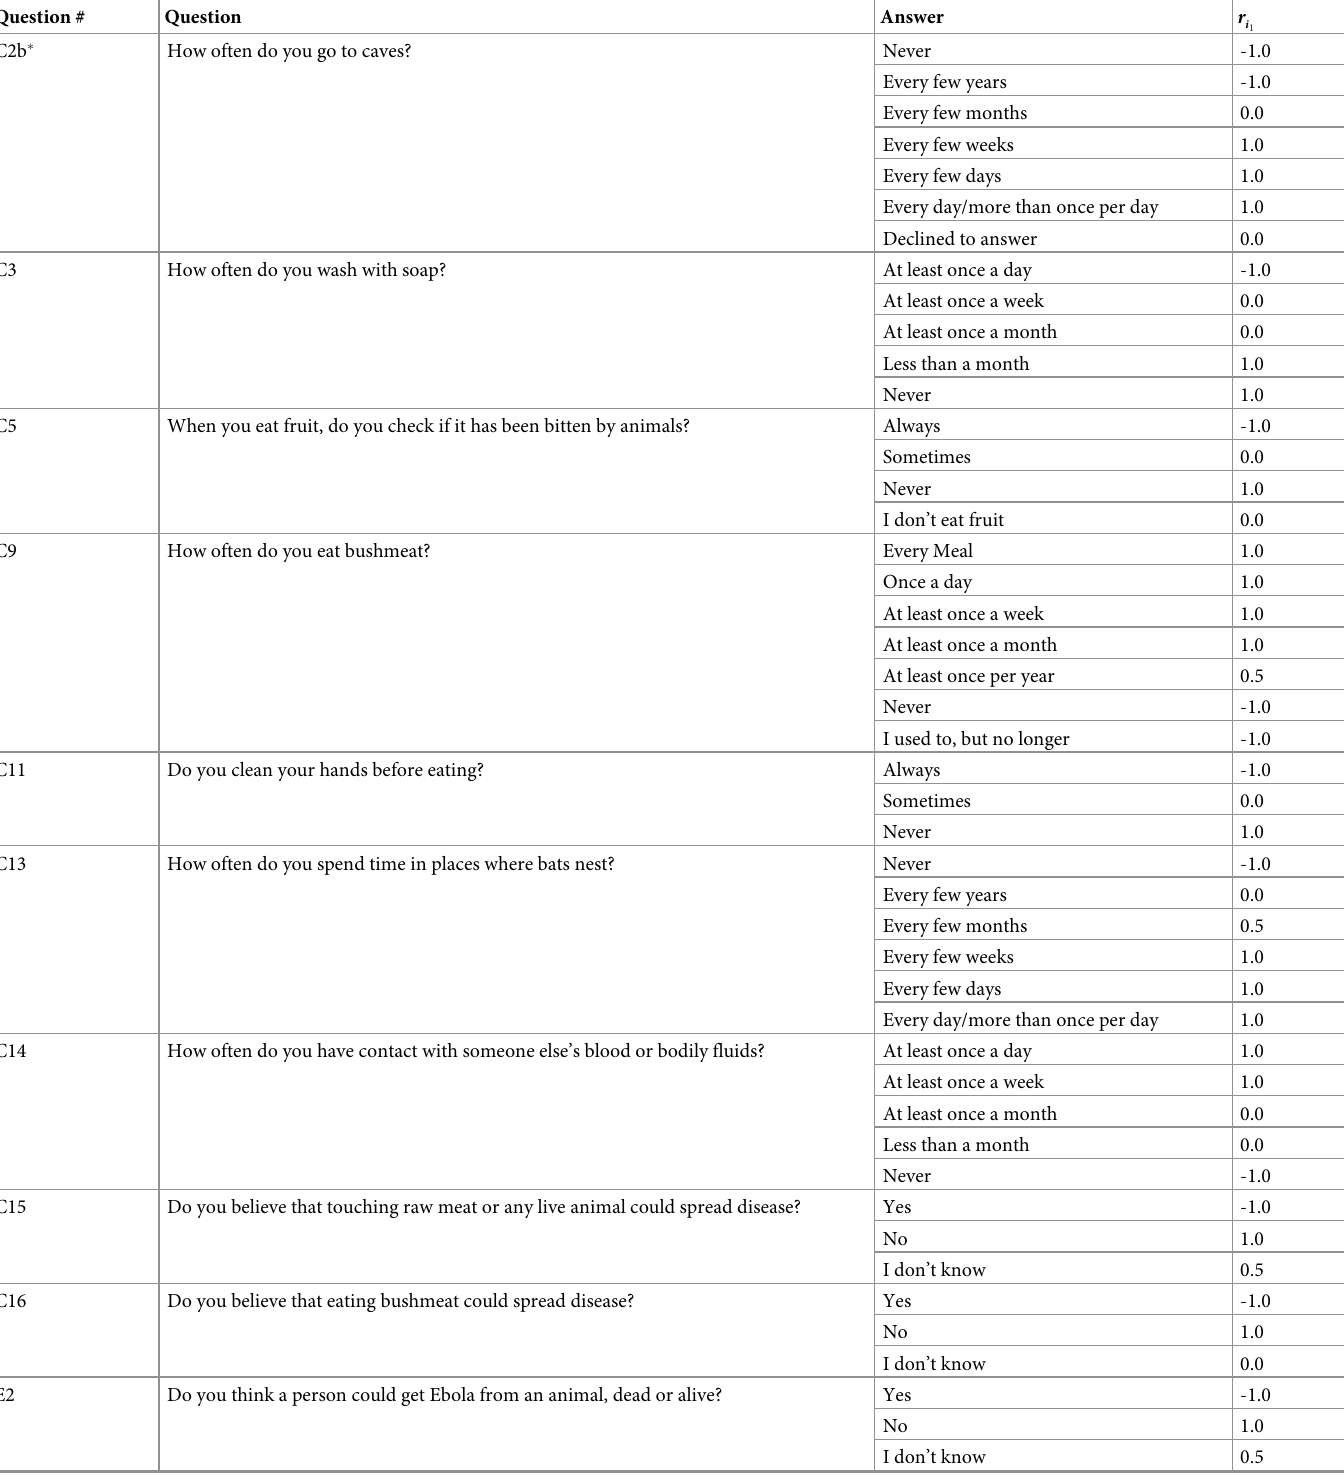
Table 5. Risk scores r